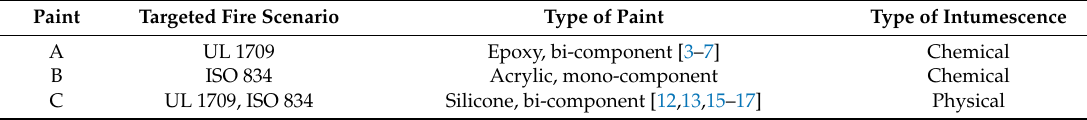
Table 1. Intumescent coatings